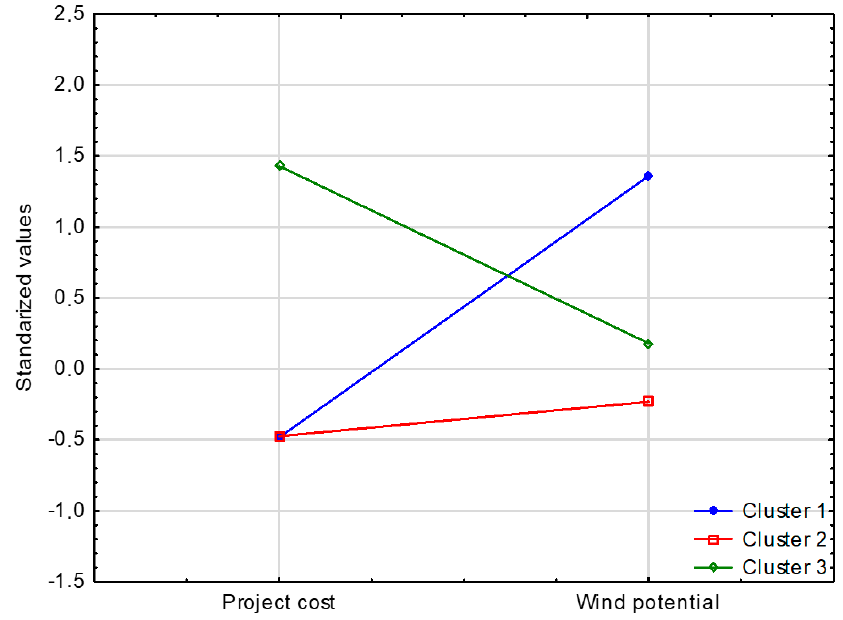
Figure 4. Standardized average project costs and wind potential.